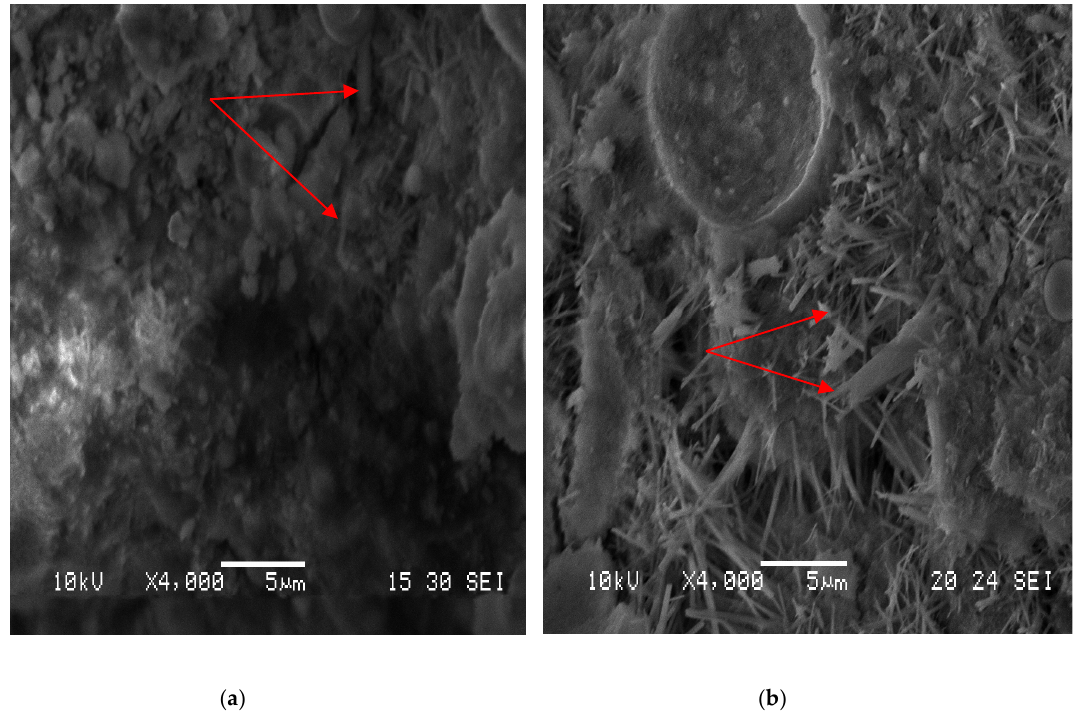
Figure 11. Microtopography of cement paste at 28 days. ( a ) Neat cement paste. ( b ) Cement paste with GM-1 at 0.5% of the mass of cement.